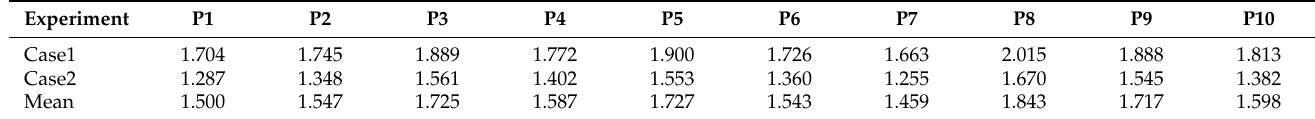
Table 7. Spatial averaged STD values of 24-h cumulative precipitation (mm) in the study domain.